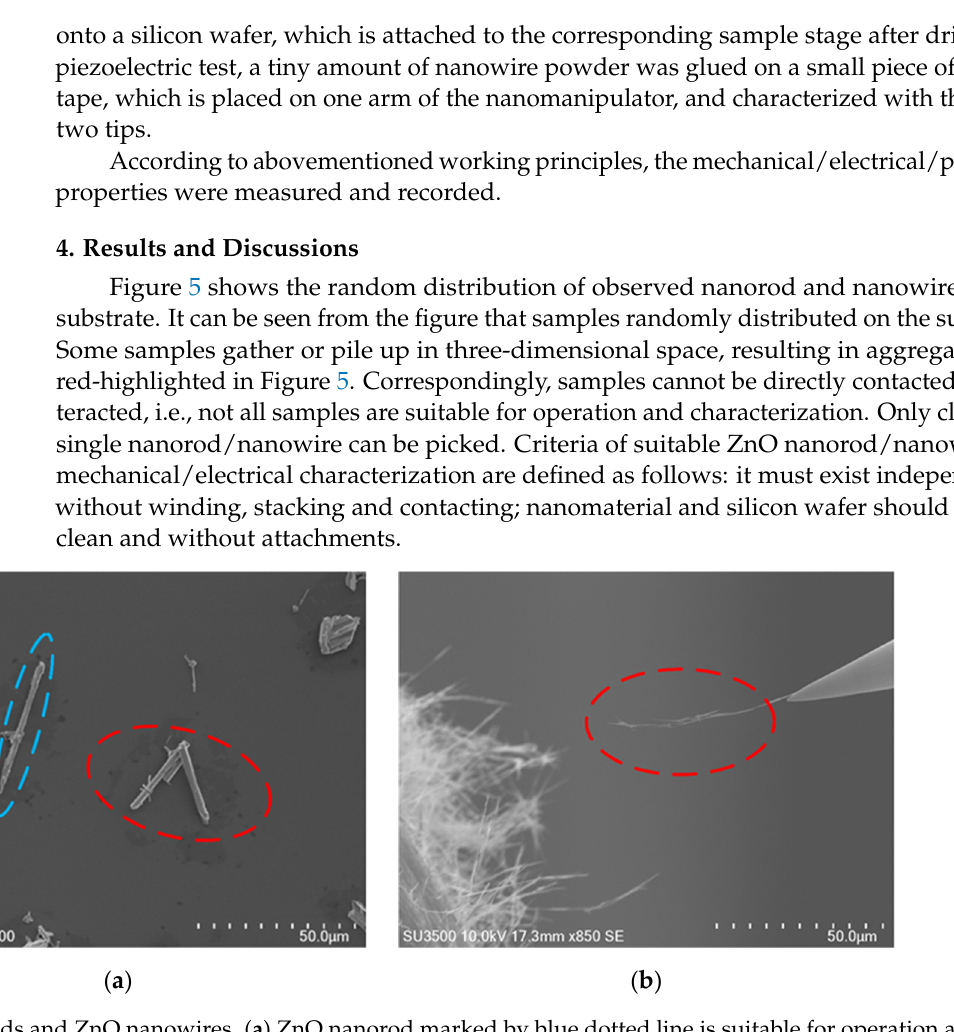
Figure 4. Mechanical/electrical characterization experimental apparatus. On the left is the electrical/piezoelectric charac- terization system (The point that a probe contacts ZnO nanorods is called irradiation point, as red dotted line marks), in the middle is the SEM, and on the right is the morphology and mechanical characterization system.